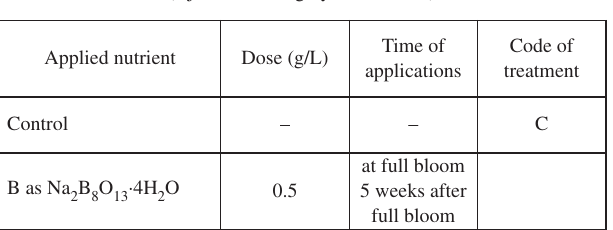
Table 1: Applied foliar fertilization system (Újfehértó, Hungary, 2008–2009)